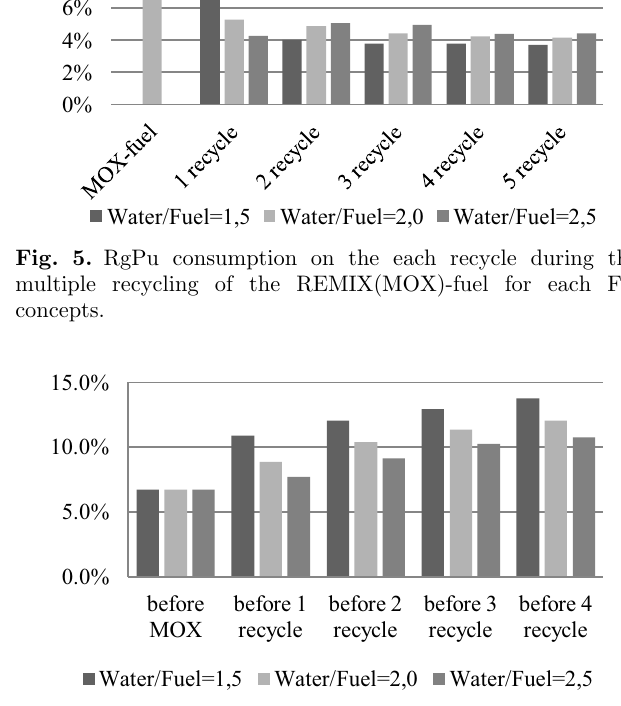
Fig. 6. The plutonium fraction in the unseparated mixture of the U and Pu isotopes, which is required for REMIX(MOX)-fuel fabrication (for each FA concepts).